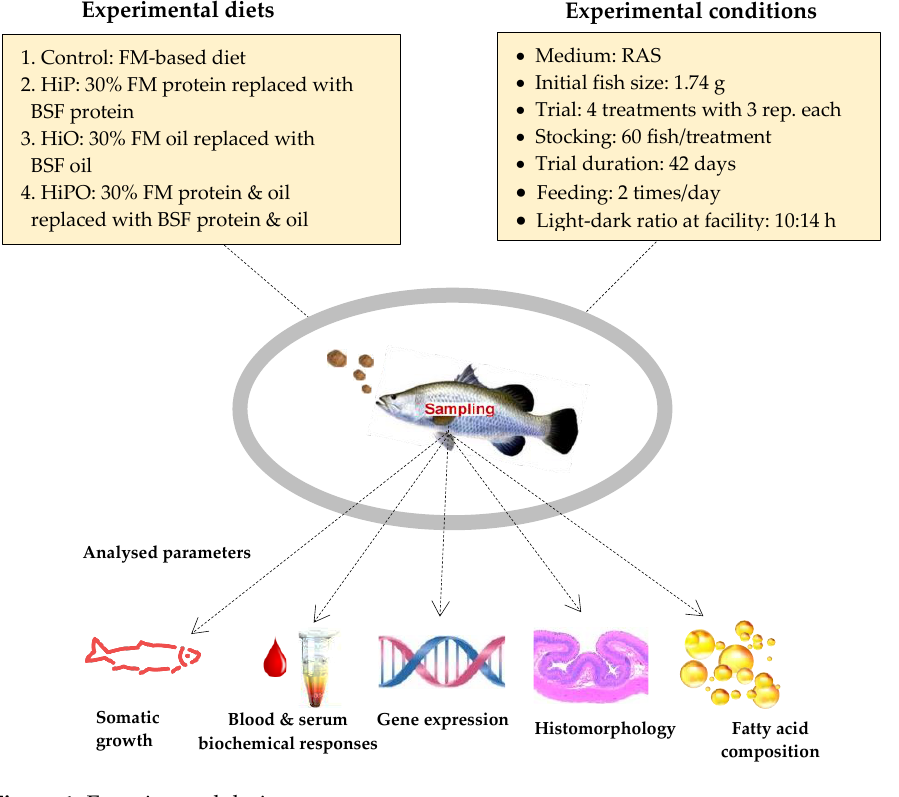
Figure 1. Experimental